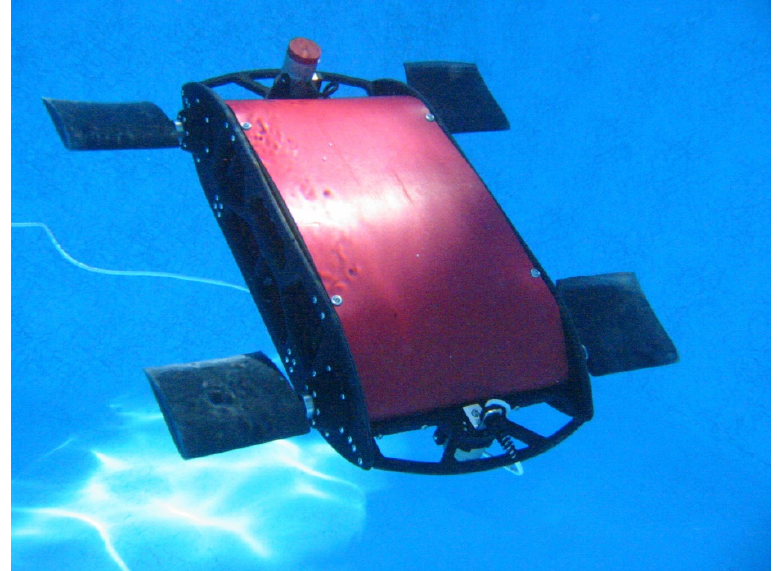
Figure 4. Madeleine, the aquatic robot imitating tetrapodal swimming. Image courtesy of John H. Long, Vassar College, USA.